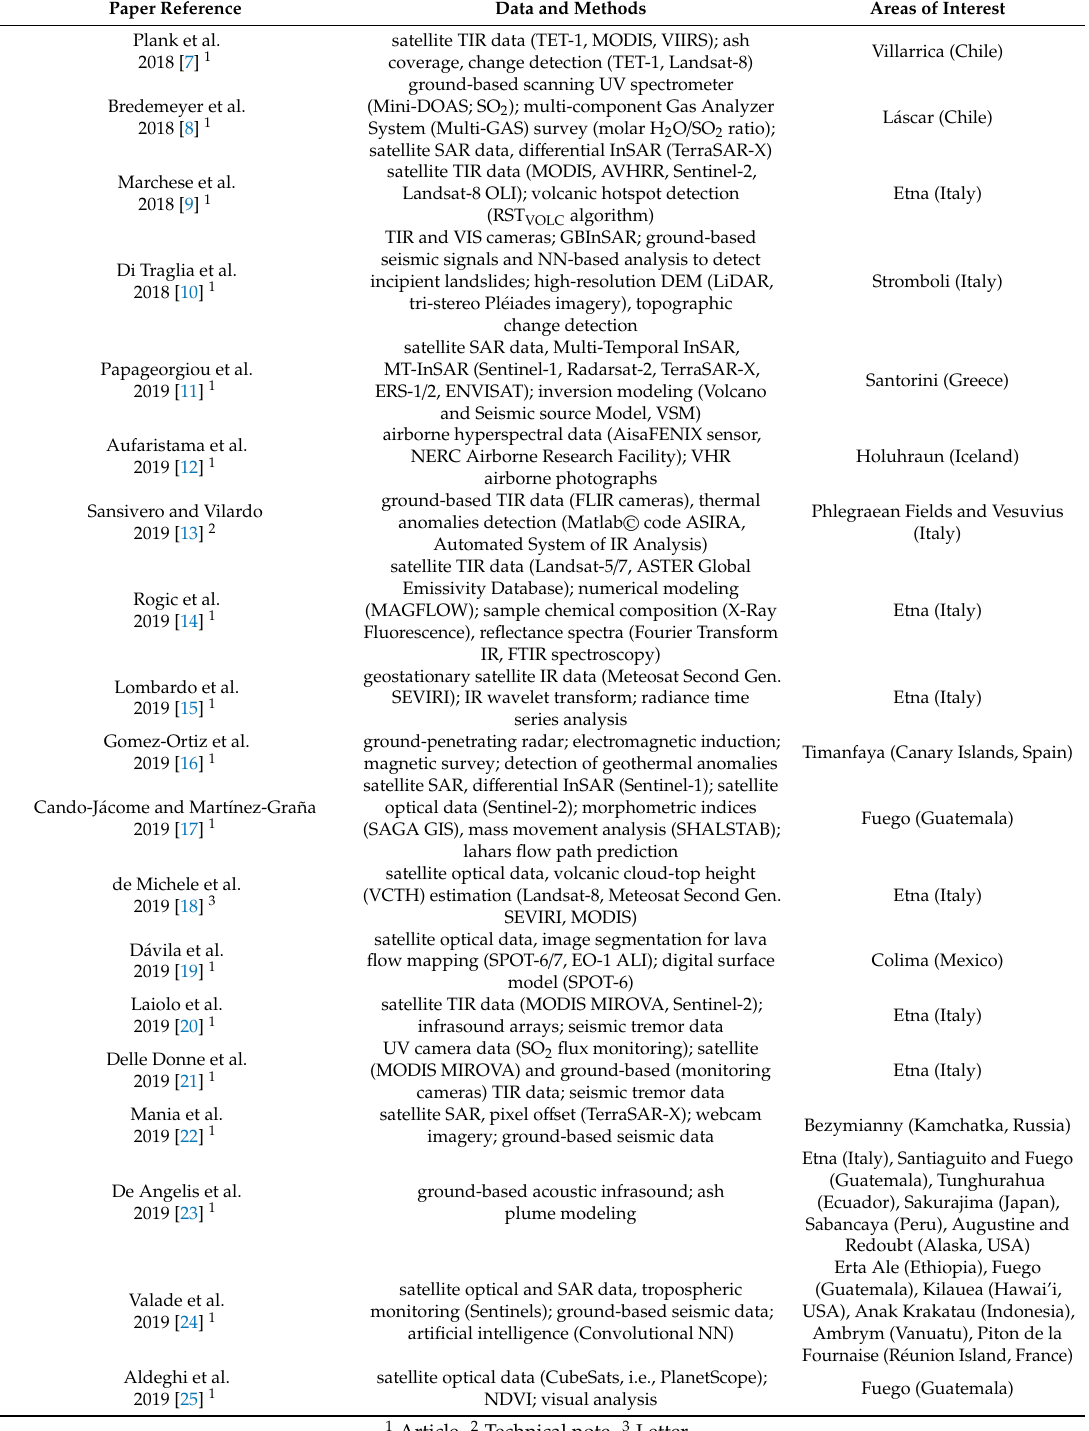
Table 1. Summary of remote sensing data, methods, and areas of interest discussed in the 19 research papers composing the Special Issue (sorted in ascending order, according to the publication date). Notation: DEM, Digital Elevation Model; IR, InfraRed; TIR, Thermal IR; SAR, Synthetic Aperture Radar; InSAR, Interferometric SAR; Ground-Based InSAR, GBInSAR; NDVI, Normalized Di ff erence Vegetation Index; NN, Neural Networks; UV, UltraViolet; VIS, Visible; VHR, Very High